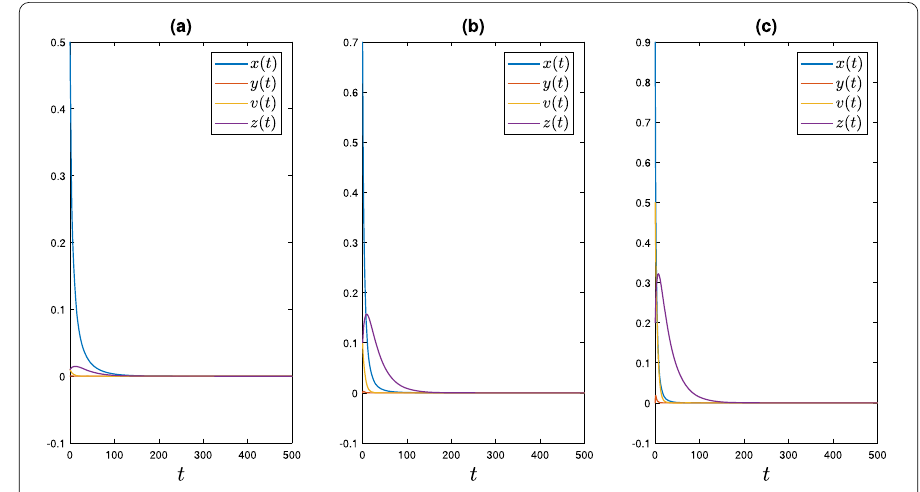
Figure 2 Numerical simulations of model (2) showing the time variation in the size of all relative populations of the model with various initial values. For these simulations, we used the following parameter values: